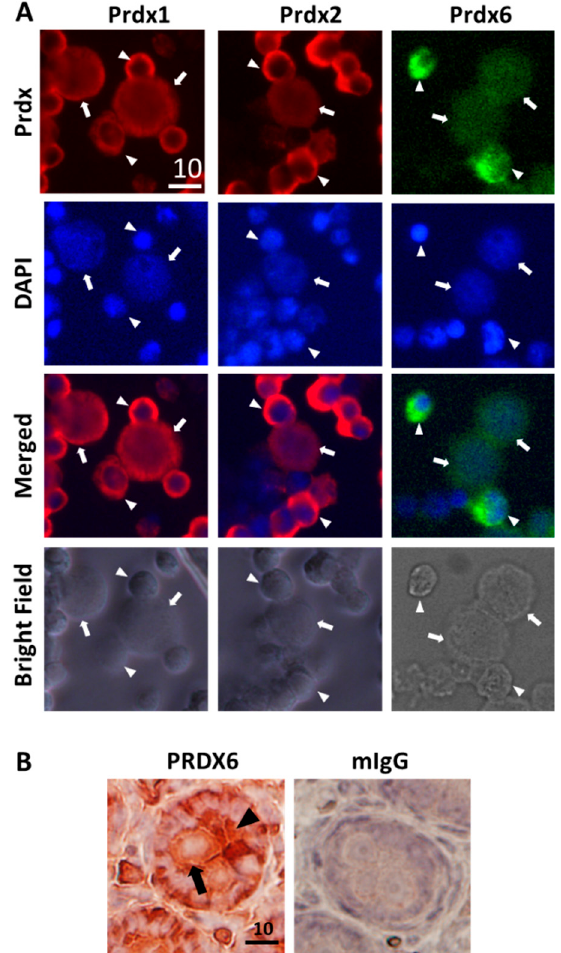
Figure 2. Protein expression of PRDX1, 2, and 6 in PND3 gonocytes. ( A ) Immunocytochemistry (ICC) analysis of PRDXs expression in cells collected right after the cell isolation procedure on cytospin slides. Low purity pooled fractions were used. White arrow: gonocytes. White arrowhead: somatic cells (Sertoli and peritubular myoid cells). ( B ) Immunohistochemistry (IHC) analysis of PND3 testis section. Representative pictures are shown. Black arrow: gonocytes. Black arrowhead: somatic cells. Scales are in μ m.